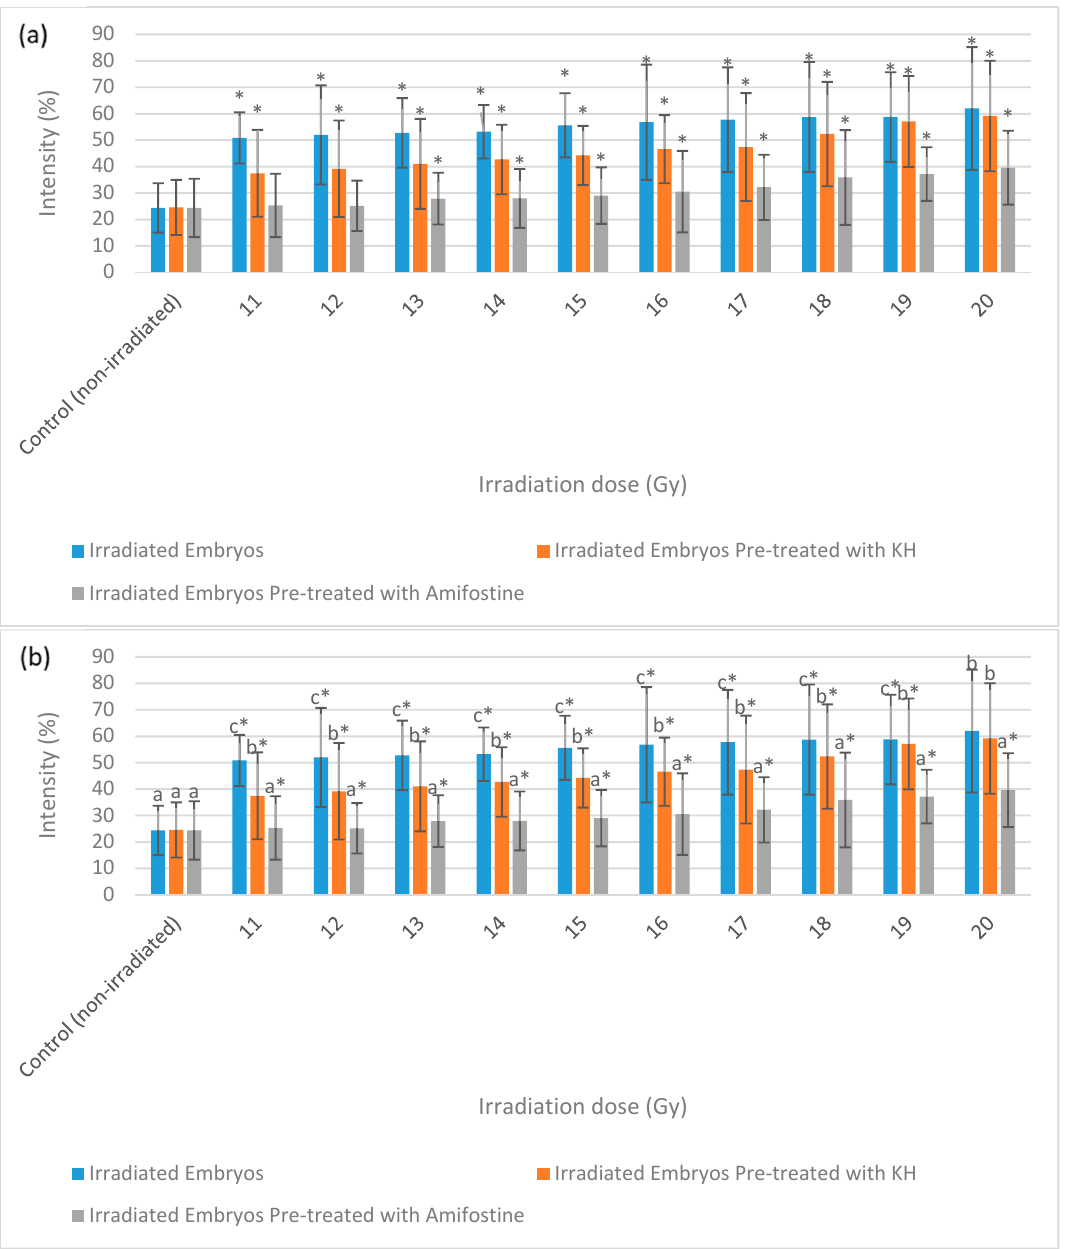
Figure 10. Intensity (%) of caspase-3 in irradiated and non-irradiated zebrafish embryos. ( a ) Caspase-3 intensity in irradiated and non-irradiated embryos. (*) indicates significant difference ( p < 0.05) as compared to control; ( b ) caspase-3 intensity in untreated and embryos pre-treated with KH and amifostine. a*, b* and c* indicate significant difference ( p < 0.05) compared to other treatment group.